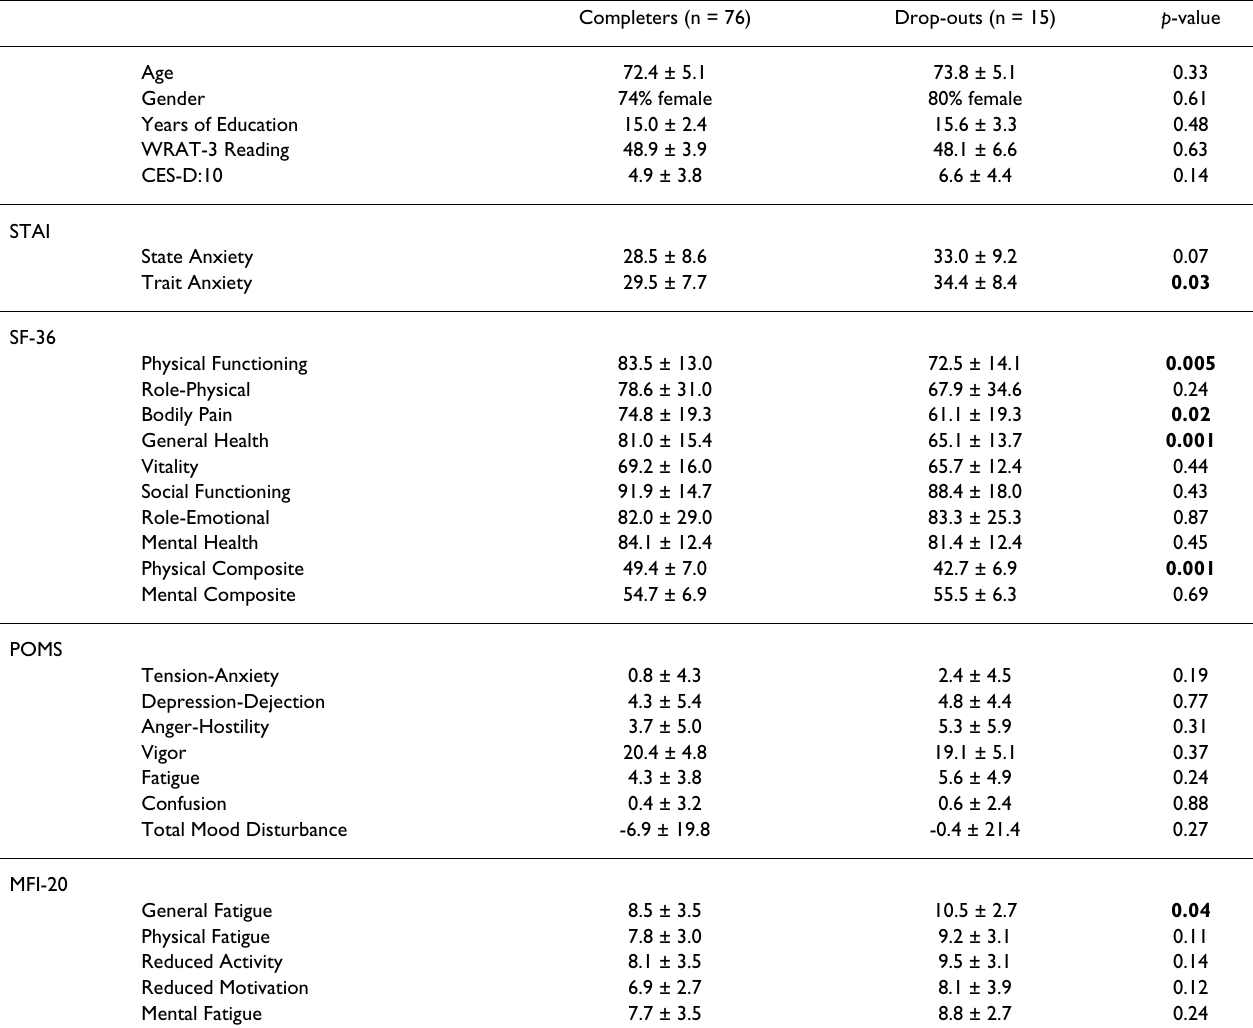
Table 3: Active intervention completers and drop-outs compared on baseline